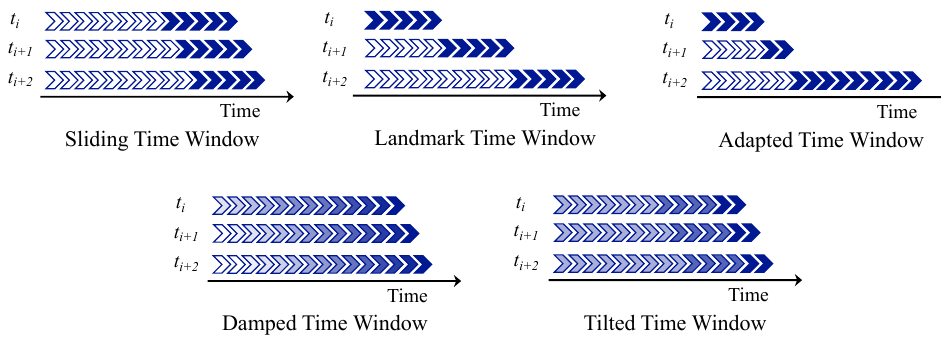
Figure 5. Different ways to segment the input data. The more concentrated the blue, the more are the observations considered in retraining the